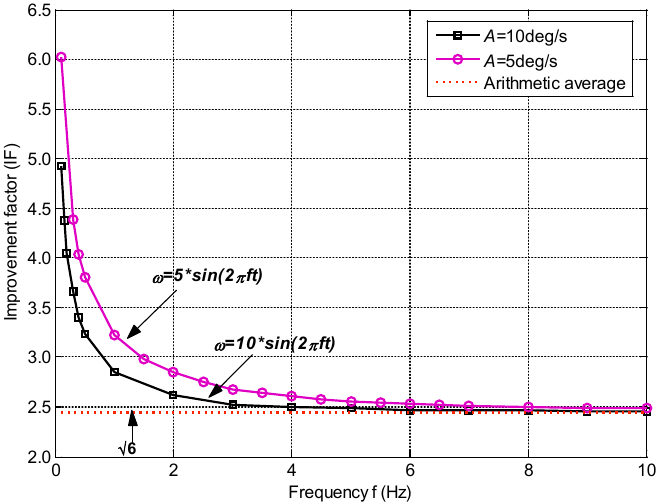
Figure 3. Plot of maximum improvement factor IF versus frequency of the input rate signal, f ranges from 0 to 10